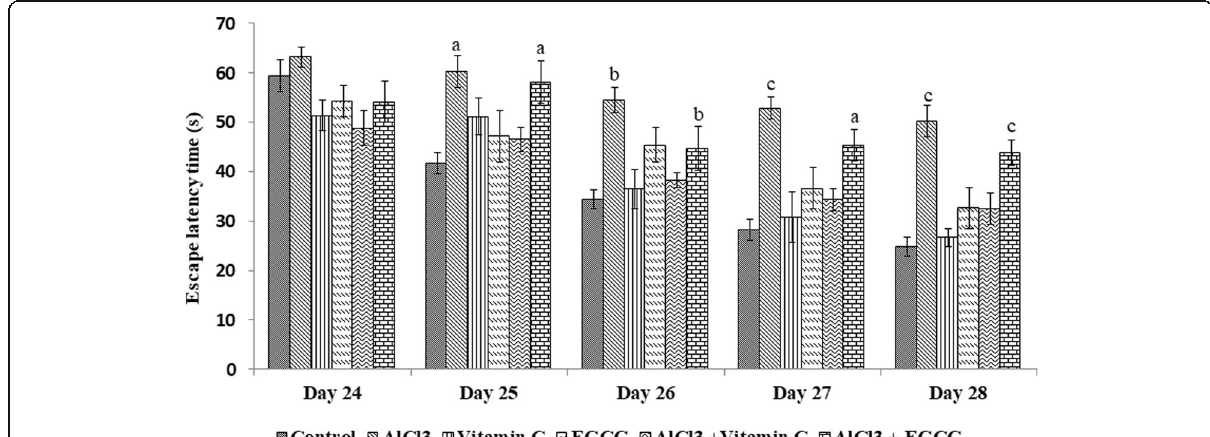
Fig. 4 Effect of EGCG on escape latency time of the rats. Values are expressed as mean ± SEM ( n = 6). a P < 0.05, b P < 0.01, and c P < 0.001 compared with control (one-way ANOVA followed by Tukey ’ s post-hoc test)